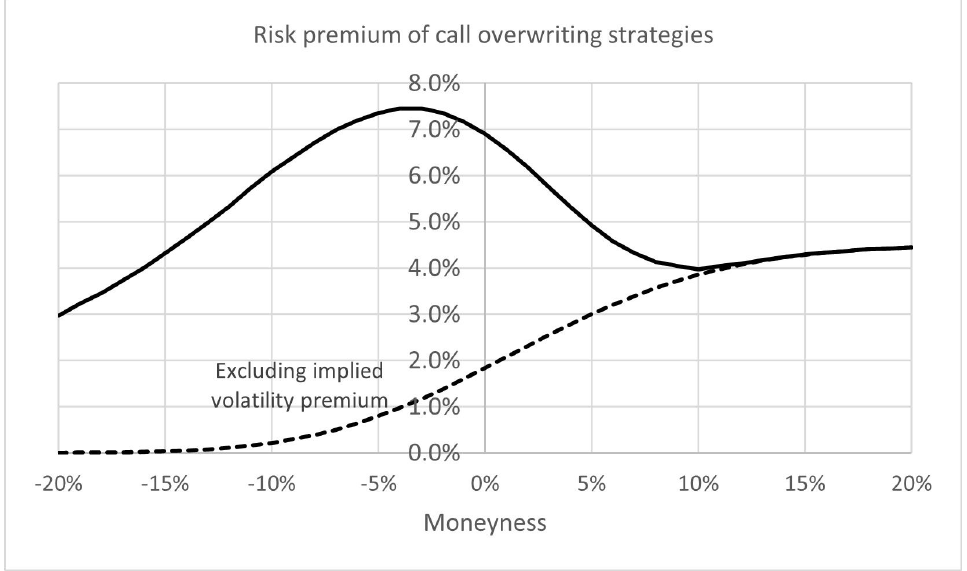
Figure 4. The risk premium for an underlying asset with an overlaid call overwriting strategy for a range of strike prices. The dotted line assumes the implied volatility is equal to the underlying asset volatility. The solid line includes the implied volatility premium in the price of the options.